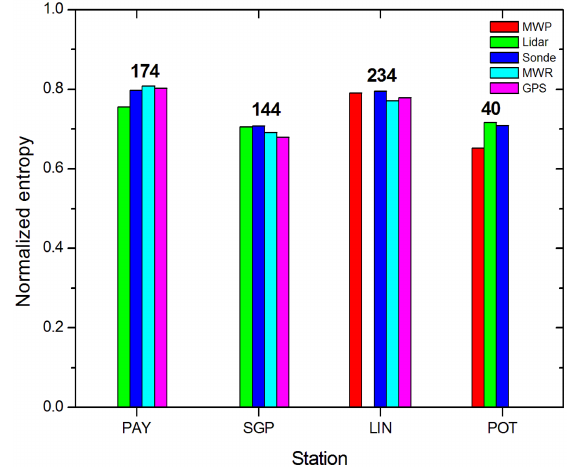
Figure 4. Comparison of the normalized entropy retrieved for the instruments measuring integrated water vapour at the Lindenberg (LIN), Payerne (PAY), Potenza (POT), and Southern Great Plains (SGP) sites. The data set considered includes all available mea- surements in 2010–2012. The numbers above the bars represent the number of cases selected, according to the quality assurance criteria for each